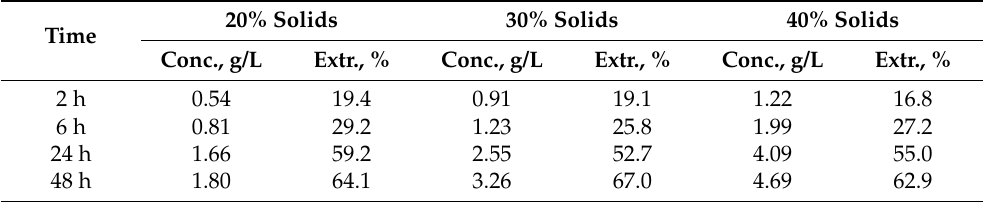
Table 4. Copper concentration in leaching solutions and its extraction with different solid contents and at different sampling